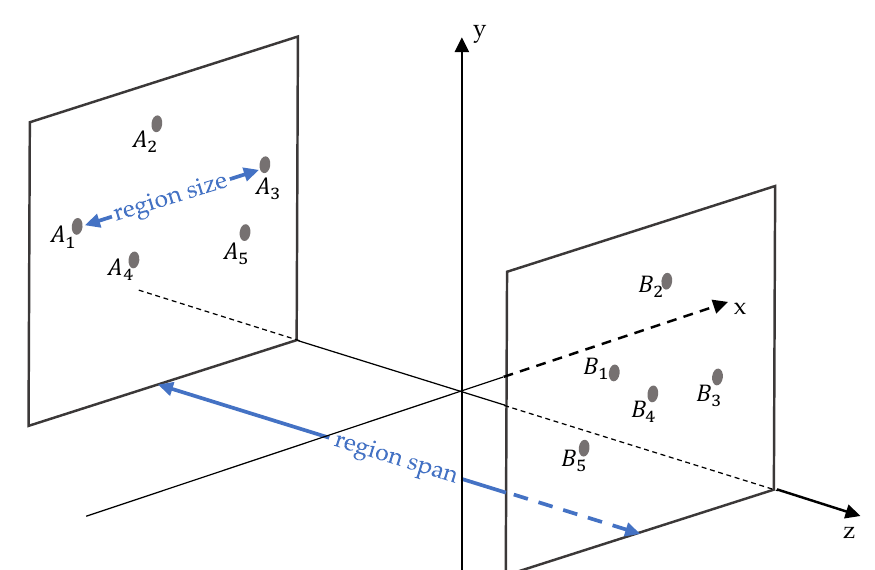
Figure 4. Definitions of region size and region span. Assume that there are region A and region B , respectively, in plane A and plane B which are perpendicular to the z-axis. In region A , A 1 and A 3 are the remotest pair of points. The distance between A 1 and A 3 denotes the region size of region A . The distance between plane A and plane B denotes the region span between region A and region B